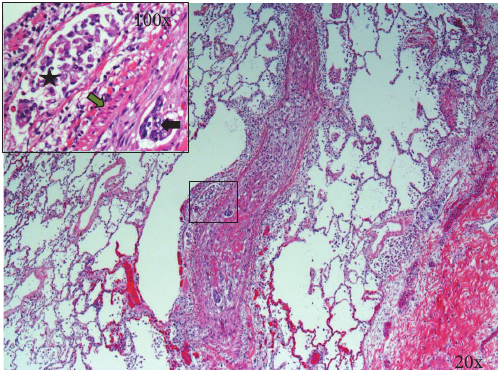
Table 2: Surgical data.